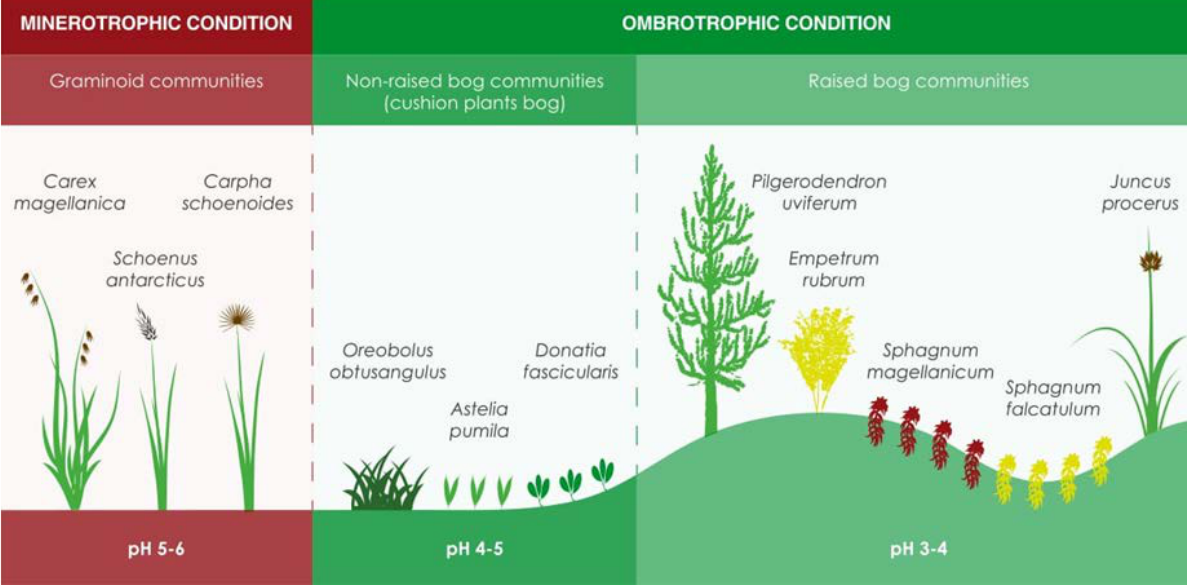
Figure 2 . Schematic diagram showing the characteristic plant species along the gradient from minerotrophic to ombrotrophic condition in southern South